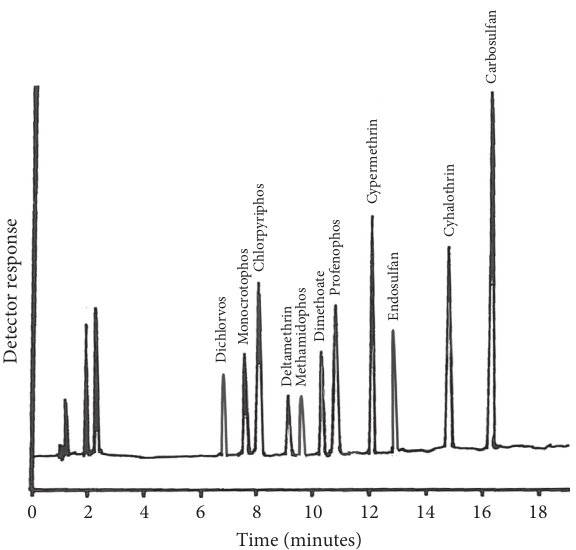
Figure 6: Chromatogram of standard pesticide analyzed by reverse phase HPLC.